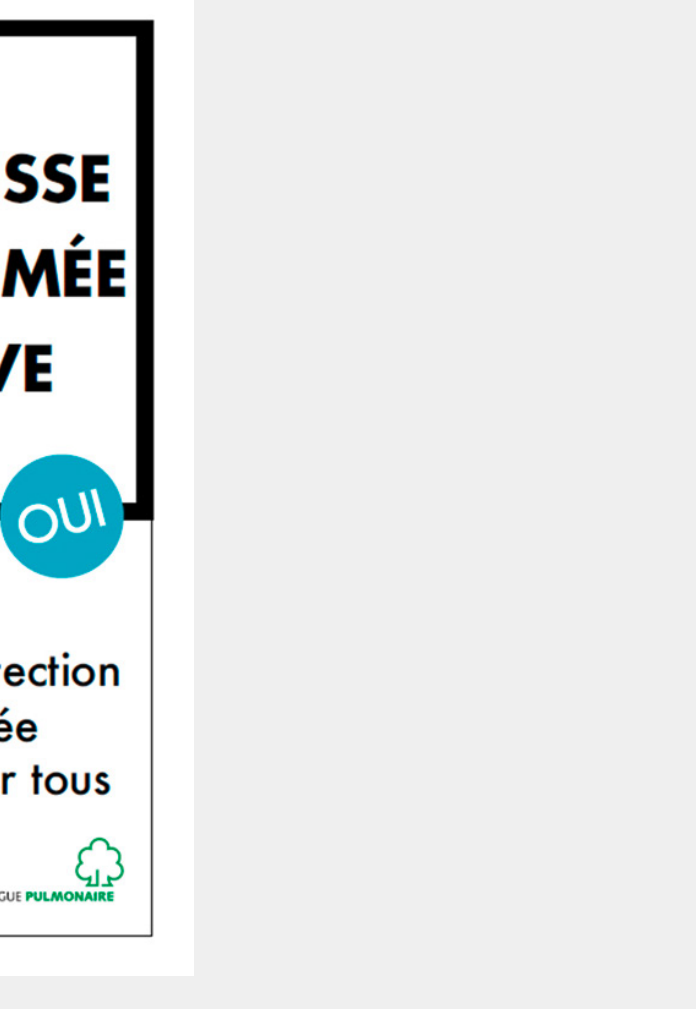
Figure 4 Sample advert in support of the